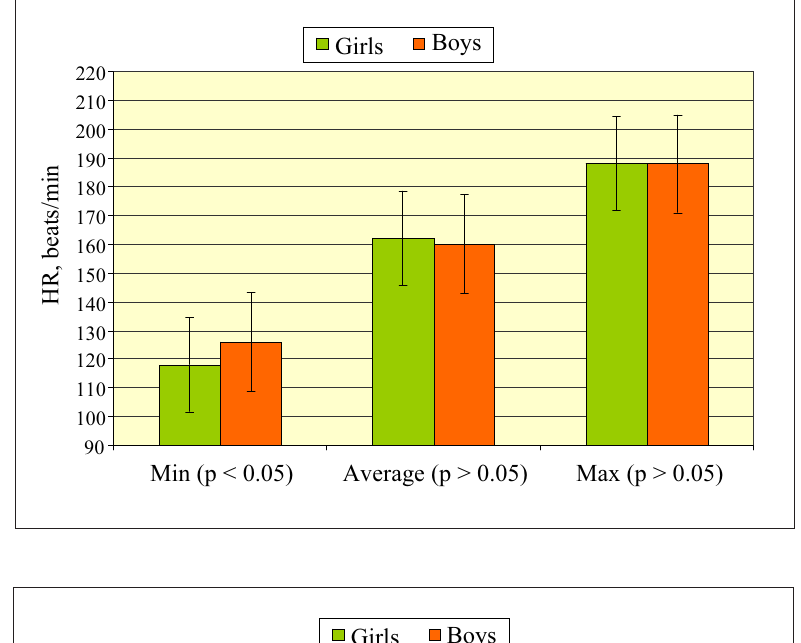
Figure 4. The indices of the heart rate for juvenile sports dancers during Latin